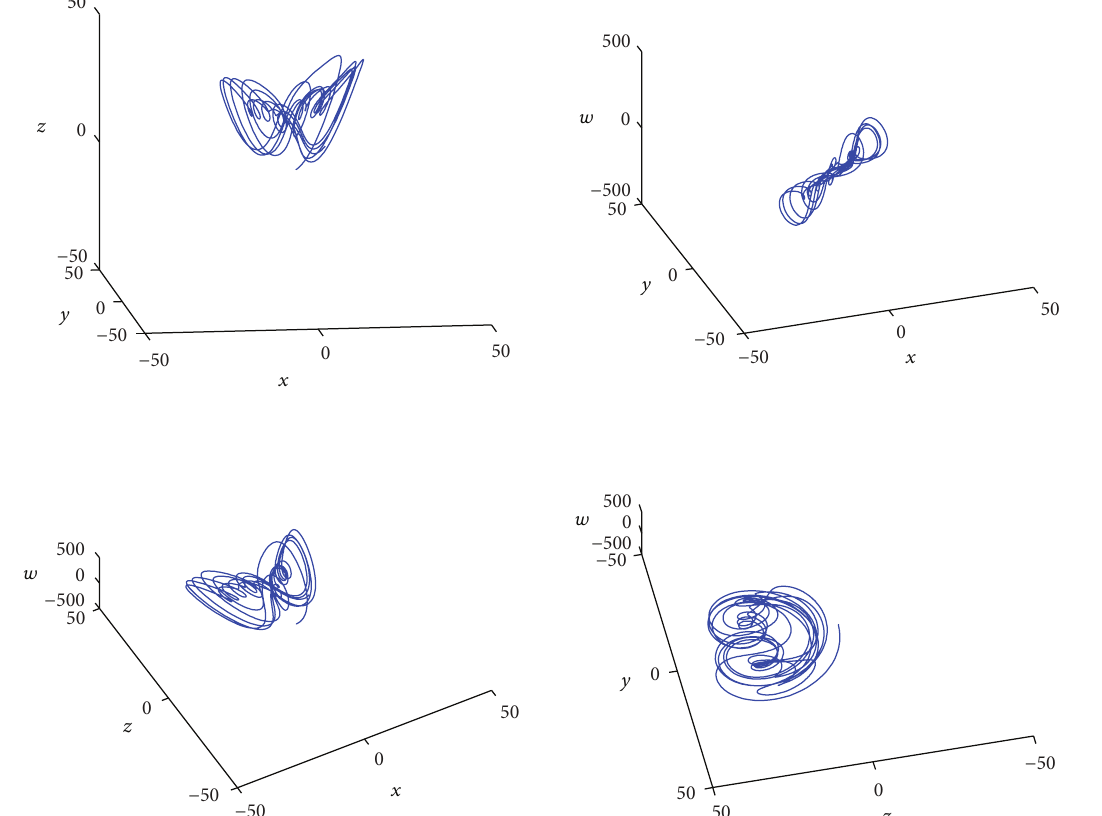
Figure 2: Response of the fractional-order hyperchaotic Lorenz system with respect to